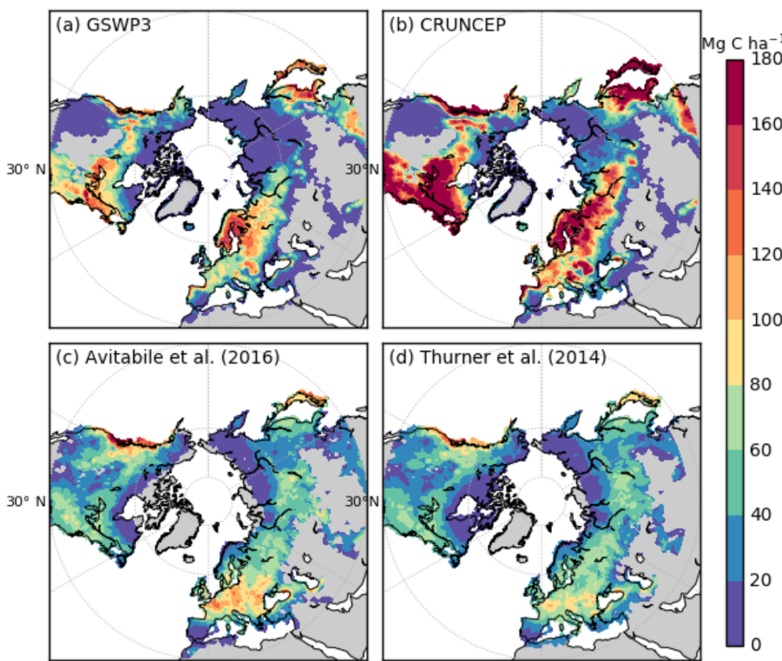
Figure 20. Total forest biomass carbon density (MgCha − 1 ) from the (a) GSWP3 and (b) CRUNCEP-forced simulations compared with satellite-derived observation products from (c) Avitabile et al. (2016) and (d) Thurner et al. (2014), averaged over the period 2000–2007.